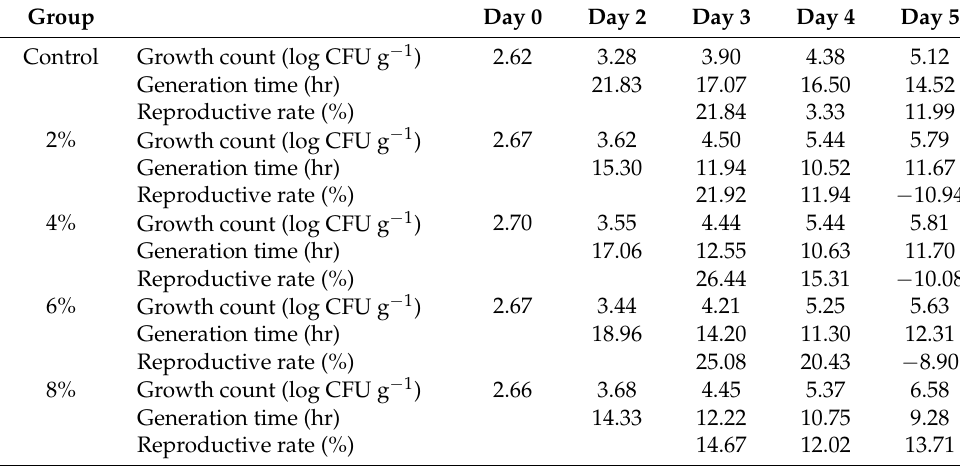
Table 4. Effects of partially substituting high-gluten flour with soy protein isolate on the growth count, generation time, and reproductive rate of Staphylococcus aureus